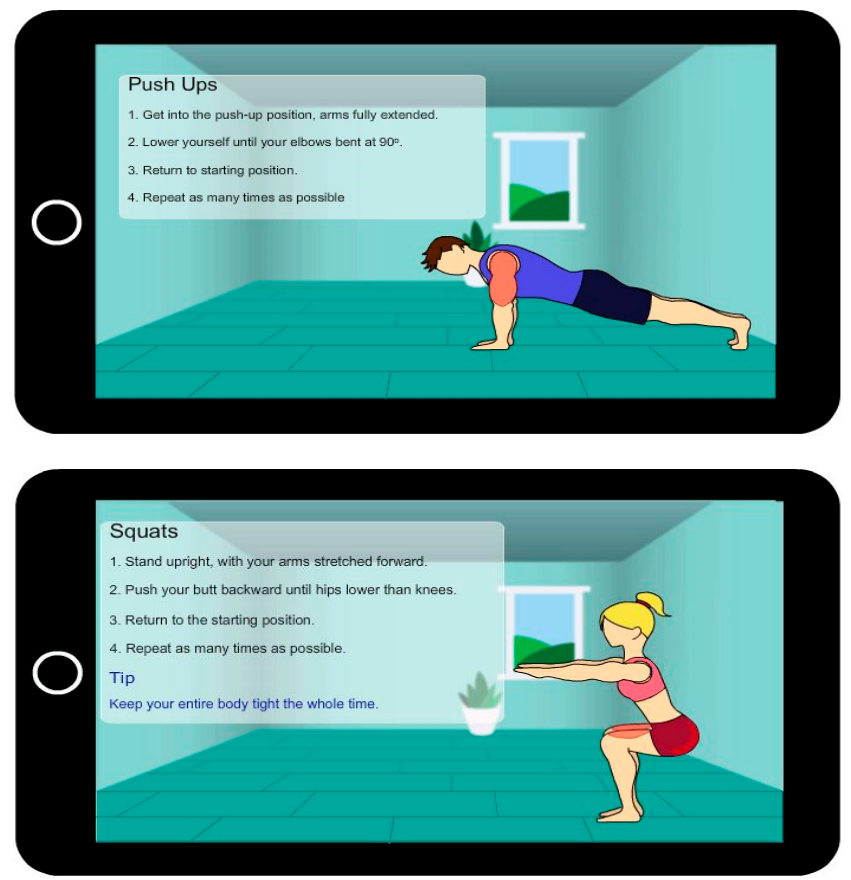
Figure 1. Two of the eight race- and gender-based push-up and squat behavior models [27].